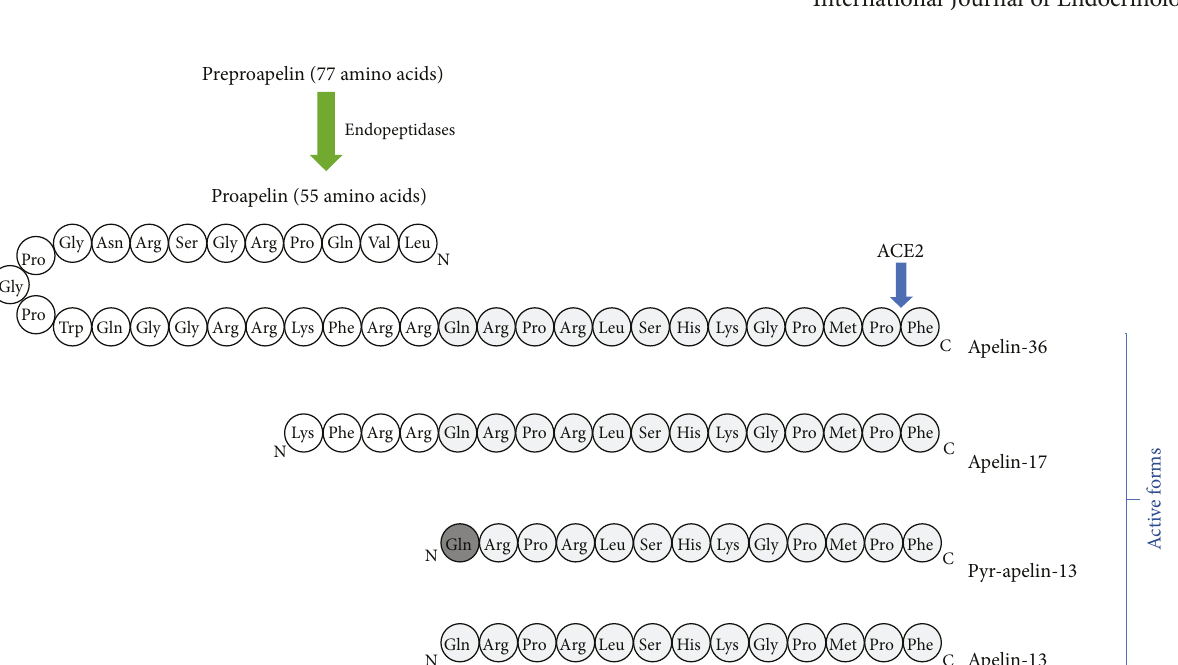
Figure 1: Amino acid sequence of native apelin and apelin isoform structure. ACE2: angiotensin I-converting enzyme